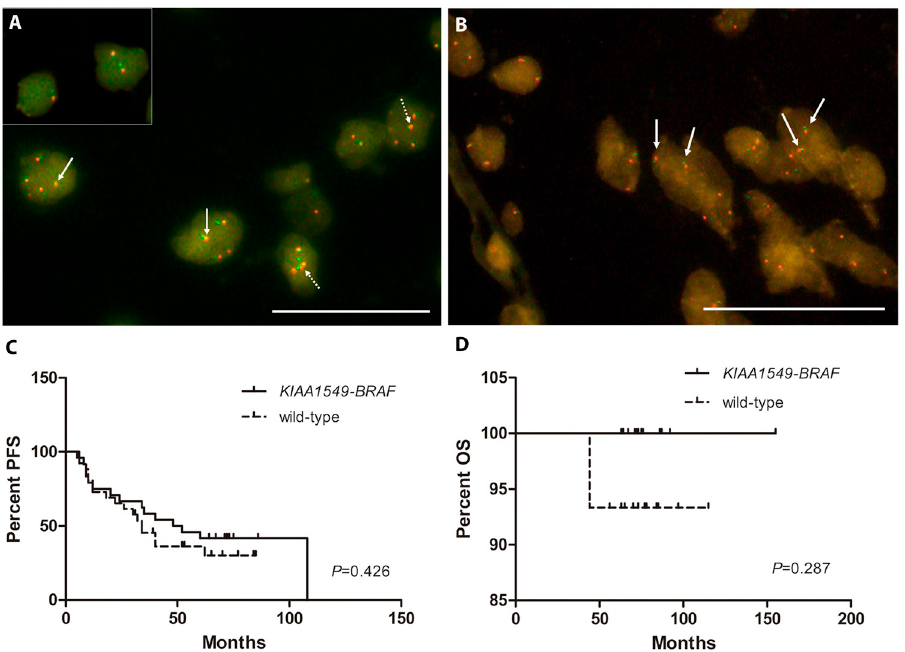
Fig 1. KIAA1549-BRAF gene fusion analysis. A) Representative pilocytic astrocytoma case showing positive fusion in interphase nuclei by FISH. BRAF probe in red, KIAA1549 probe in green and overlapped probes in yellow (continuous arrows). BRAF gene duplication is indicated by dotted arrows. Insert depicts another fusion-positive case without BRAF gene duplication. Scale bar represents 50 μ m at 1000x magnification. B) Representative image for a KIAA1549-BRAF gene fusion-negative case (arrows show contiguous but separated red and green signals). BRAF probe in red, KIAA1549 probe in green. Scale bar represents 50 μ m at 1000x magnification. C) Kaplan-Meyer progression free survival analysis in LGG. D) Kaplan-Meyer overall survival analysis in